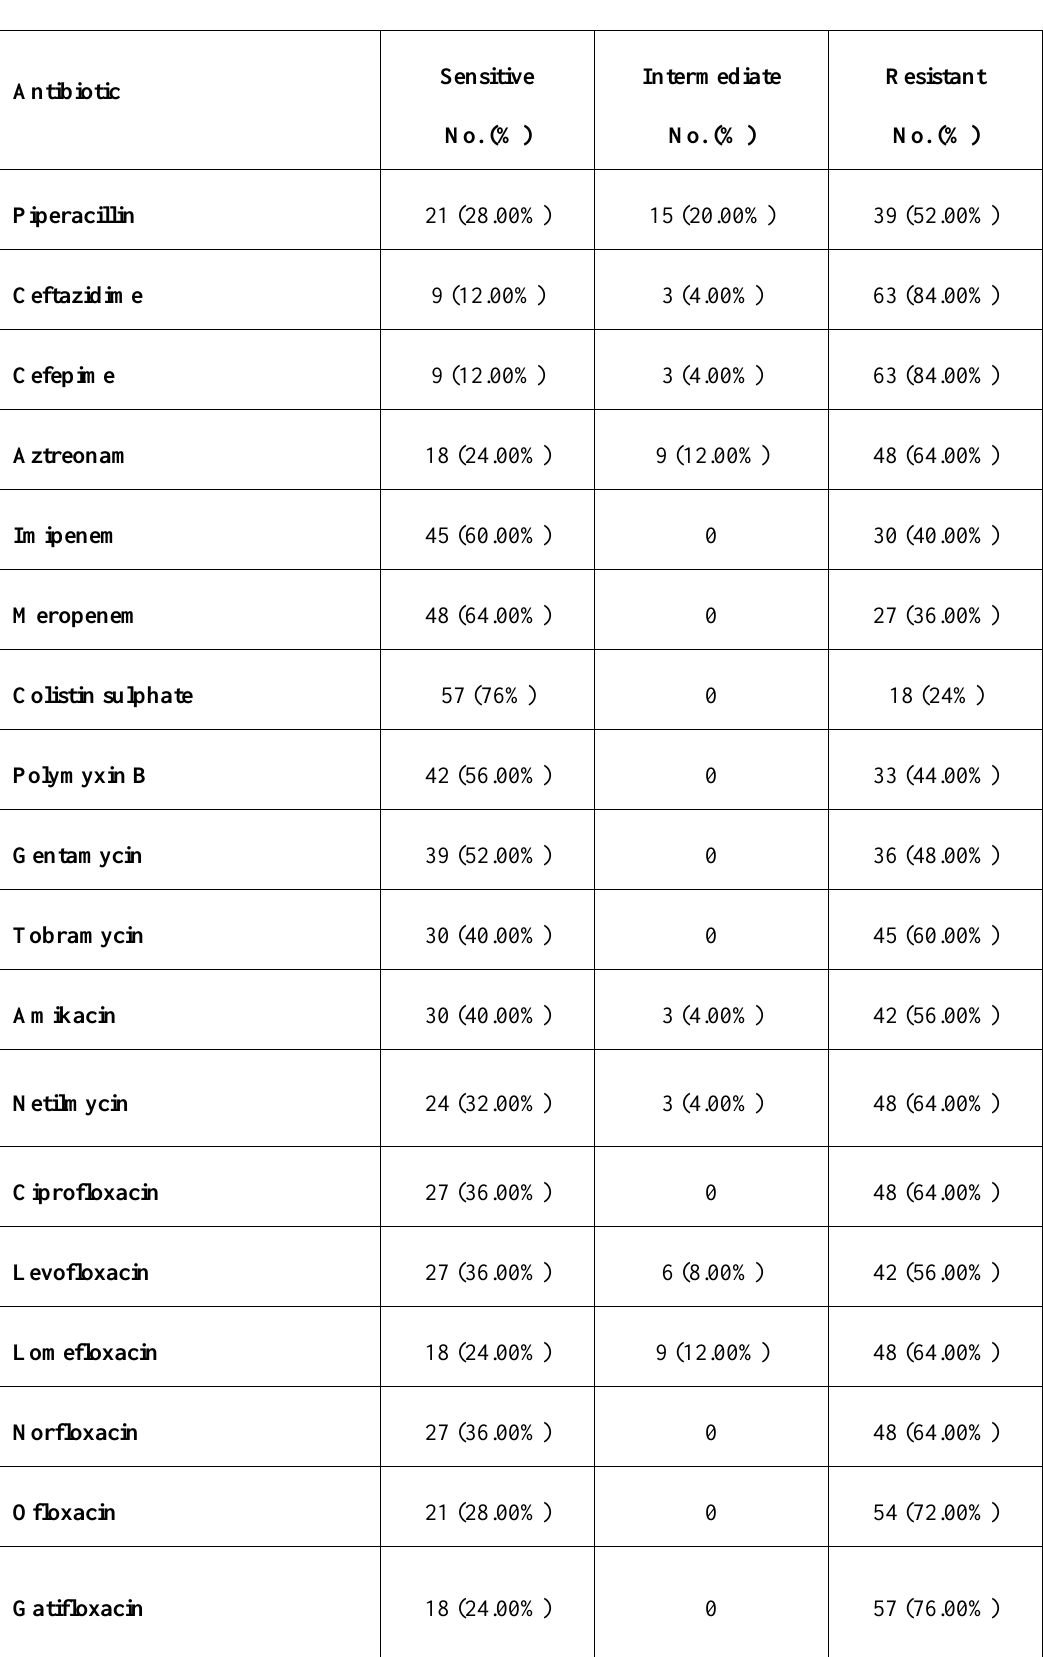
Table 4. Antimicrobial susceptibility profile of P. aeruginosa